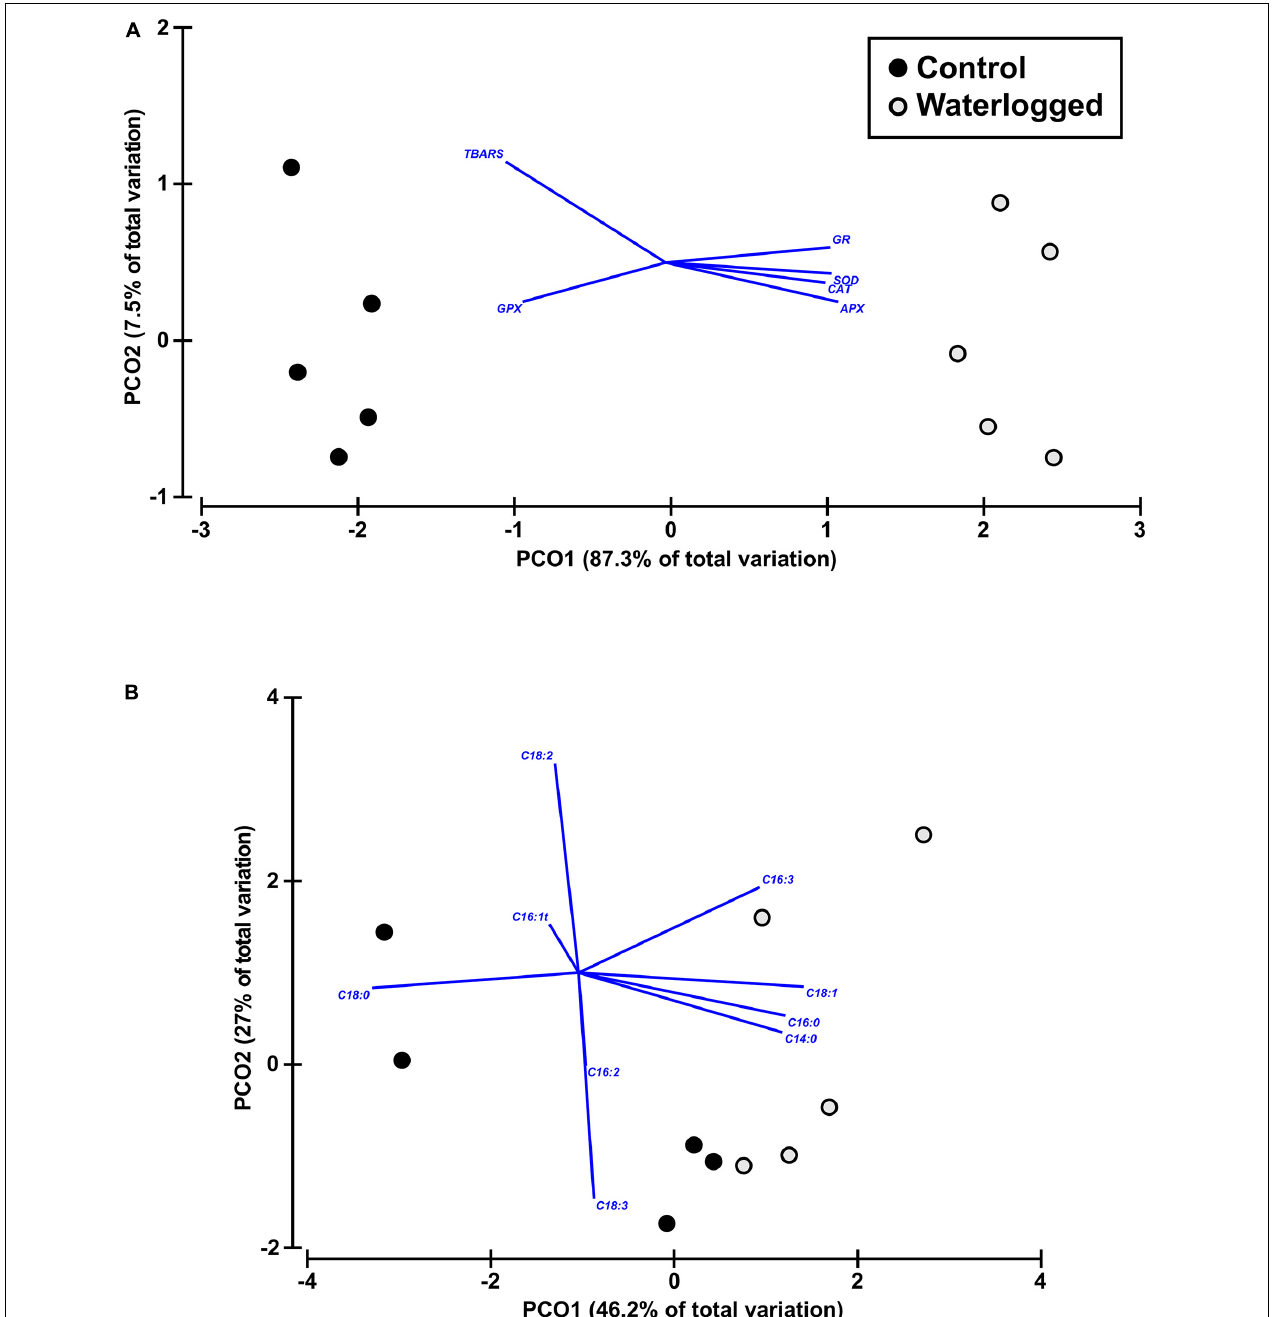
FIGURE 14 | Canonical analysis plot based on oxidative stress (antioxidant enzymes and lipid peroxidation) data (A) , and fatty acid profile (B) in leaves of control plants (black circles) and waterlogged plants (gray circles) of Spartina patens after 30 days ( n = 5, different letters indicate significant differences at p < 0.05).